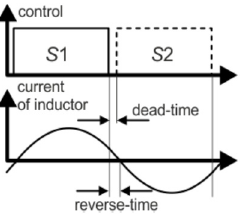
Figure 7. A method for operation with maximum efficiency (Zero Voltage Switching (ZVS), nearly Zero Current Switching (ZCS) (Low-Current Switching—LCS) turn-off and decreased RMS current in comparison to full ZCS case): the use of pattern P2 for high efficiency (pattern P2HE).